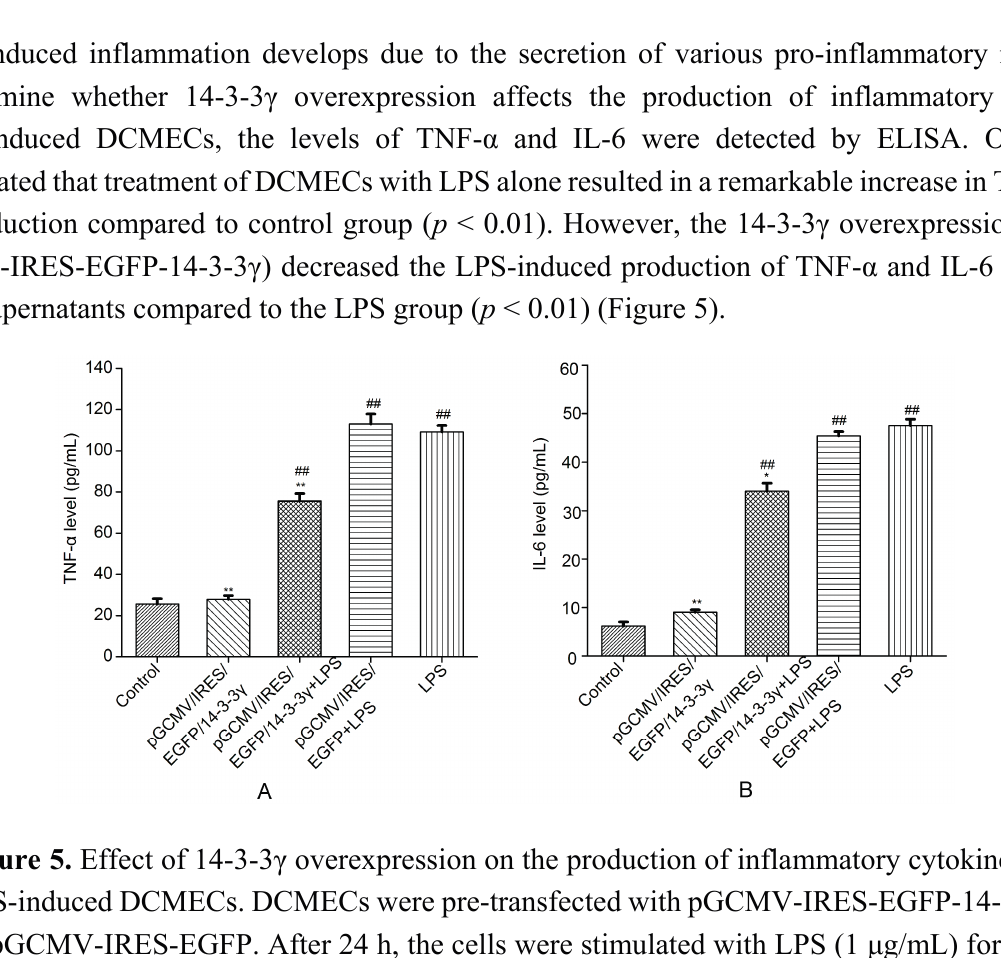
p38 MAPK in LPS-induced DCMECs compared to the LPS group ( p < 0.05 or p < 0.01), but without inhibitory effect on phosphorylation of JNK (Figure